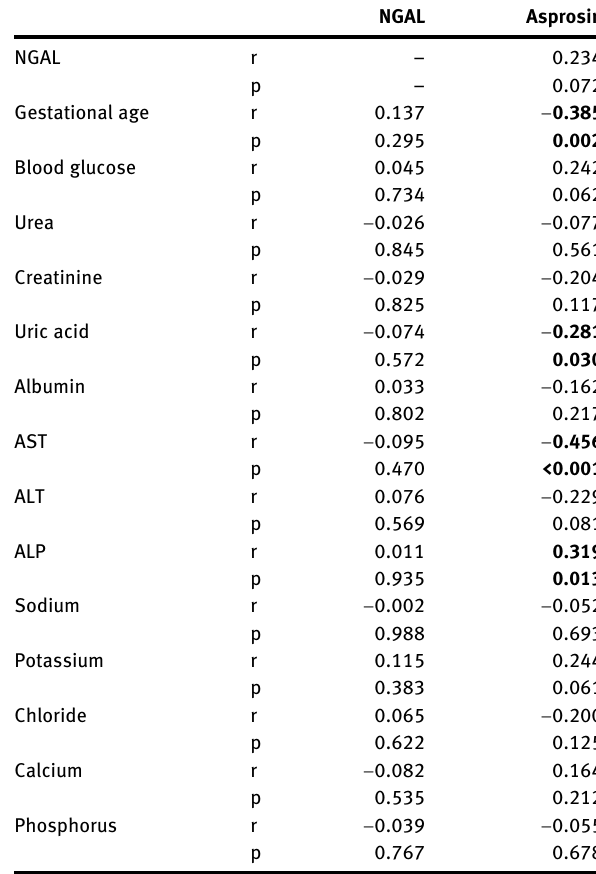
Table  : Diagnostic performance of the NGAL and asprosin levels. Table  : Correlations between NGAL, asprosin and other NGAL